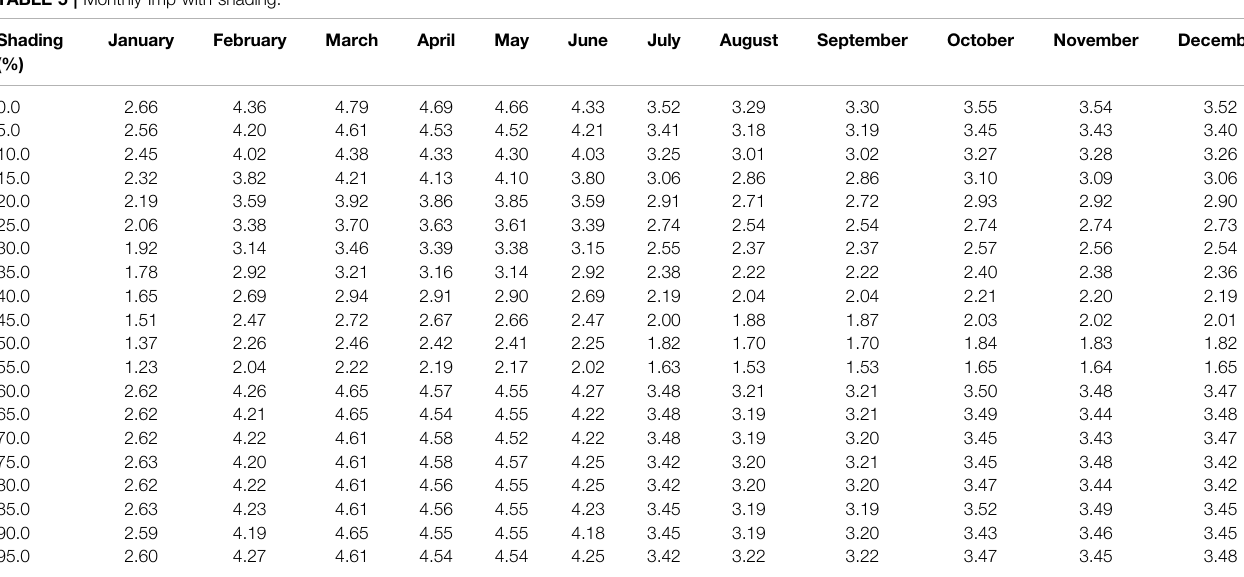
TABLE 5 | Monthly Imp with shading. Shading (%)